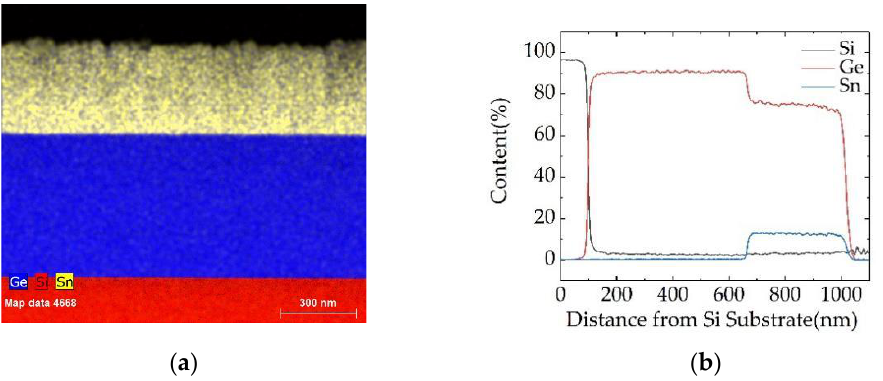
8 of 11 Figure 6. XTEM images of Ge 1−x Sn x film deposited at 240 ° C: ( a ) full view of the film by scanning TEM; ( b ) high resolution TEM at Ge/Si interface; ( c ) high resolution TEM at Ge/Ge 1−x Sn x interface; ( d – f ) show the FFT patterns corresponding to the various regions in ( c ). Electron dispersive X-ray (EDX) spectroscopy was performed to identify the ele- mental composition of the Ge and Ge 1-x Sn x films, and the results are shown in Figure 7. Figure 7a shows a spectral scan of the concentration values of uniformly distributed Sn,